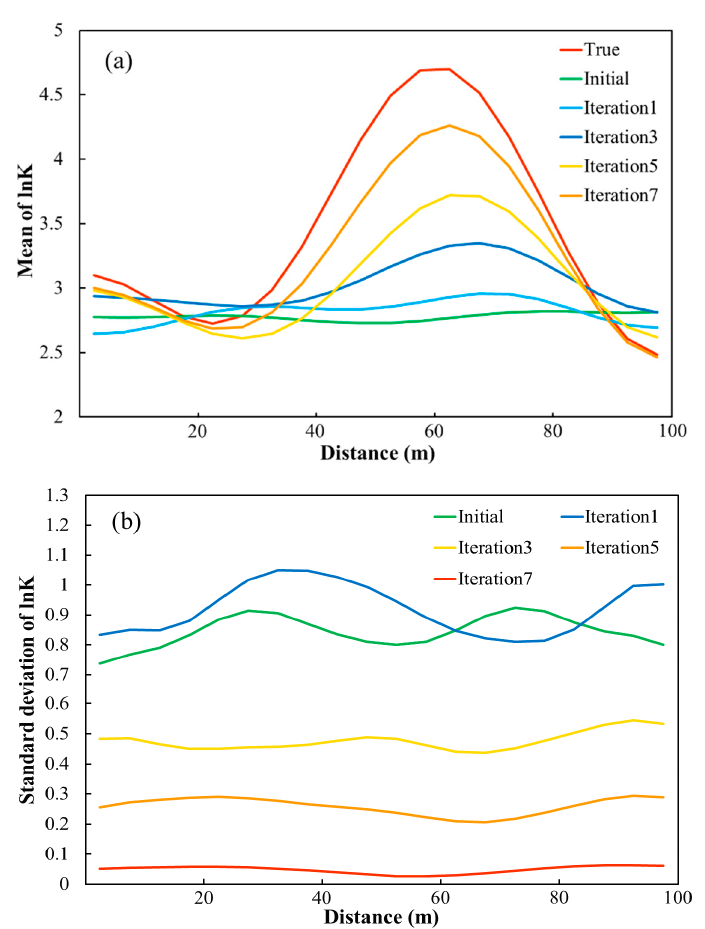
Figure 4. ( a ) is the mean of the log-conductivity field at selected iterations. The red line in ( a ) denotes the